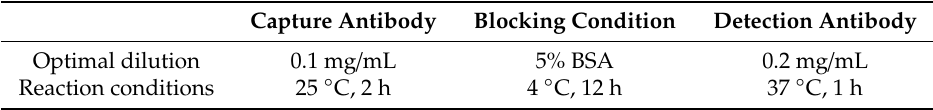
Table 1. Best detection conditions for fluorescent microsphere detection